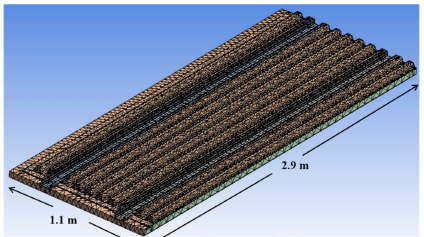
Figure 10. Finite element modeling